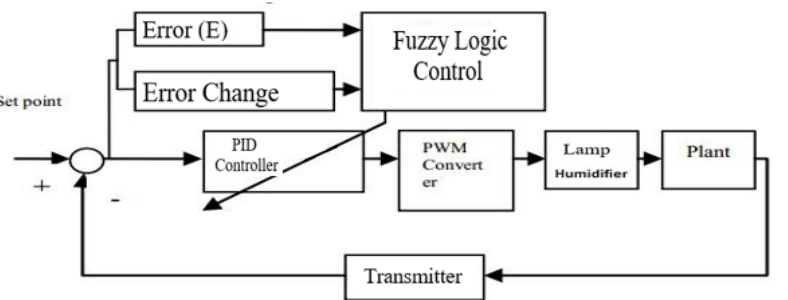
Figure 6. Block diagram of Fuzzy-PID hybrid control on the baby incubator.